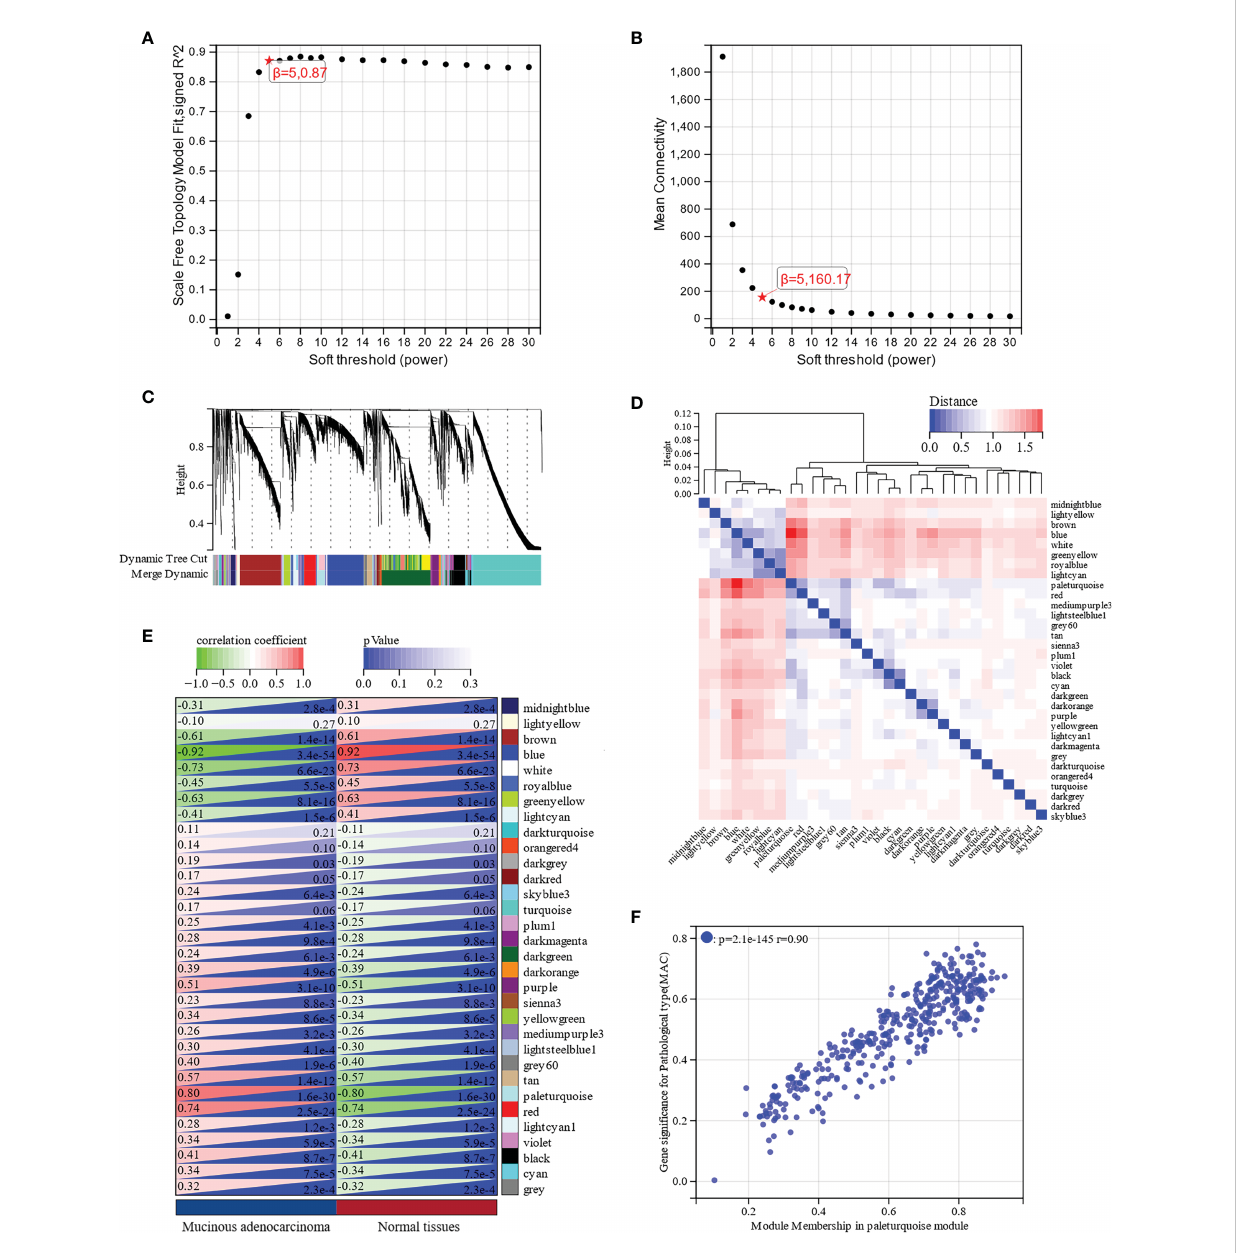
FIGURE 3 Identi fi cation of key modules associated with MAC through Weighted Gene Co-Expression Network Analysis (WGCNA). (A) Scale free topology model fi t analysis for various soft-thresholding powers. (B) Mean connectivity analysis for various soft-thresholding powers. (C) Module dendrogram of all differentially expressed genes (DEGs) clustered based on a dissimilarity measure. (D) Clustering of module eigengenes and a heatmap of adjacent eigengenes. (E) Heatmap of the correlation between module eigengenes and MAC. Each cell contains the correlation coef fi cient and p value. (F) Scatter plot of module membership in paleturquoise module and gene signi fi cance for